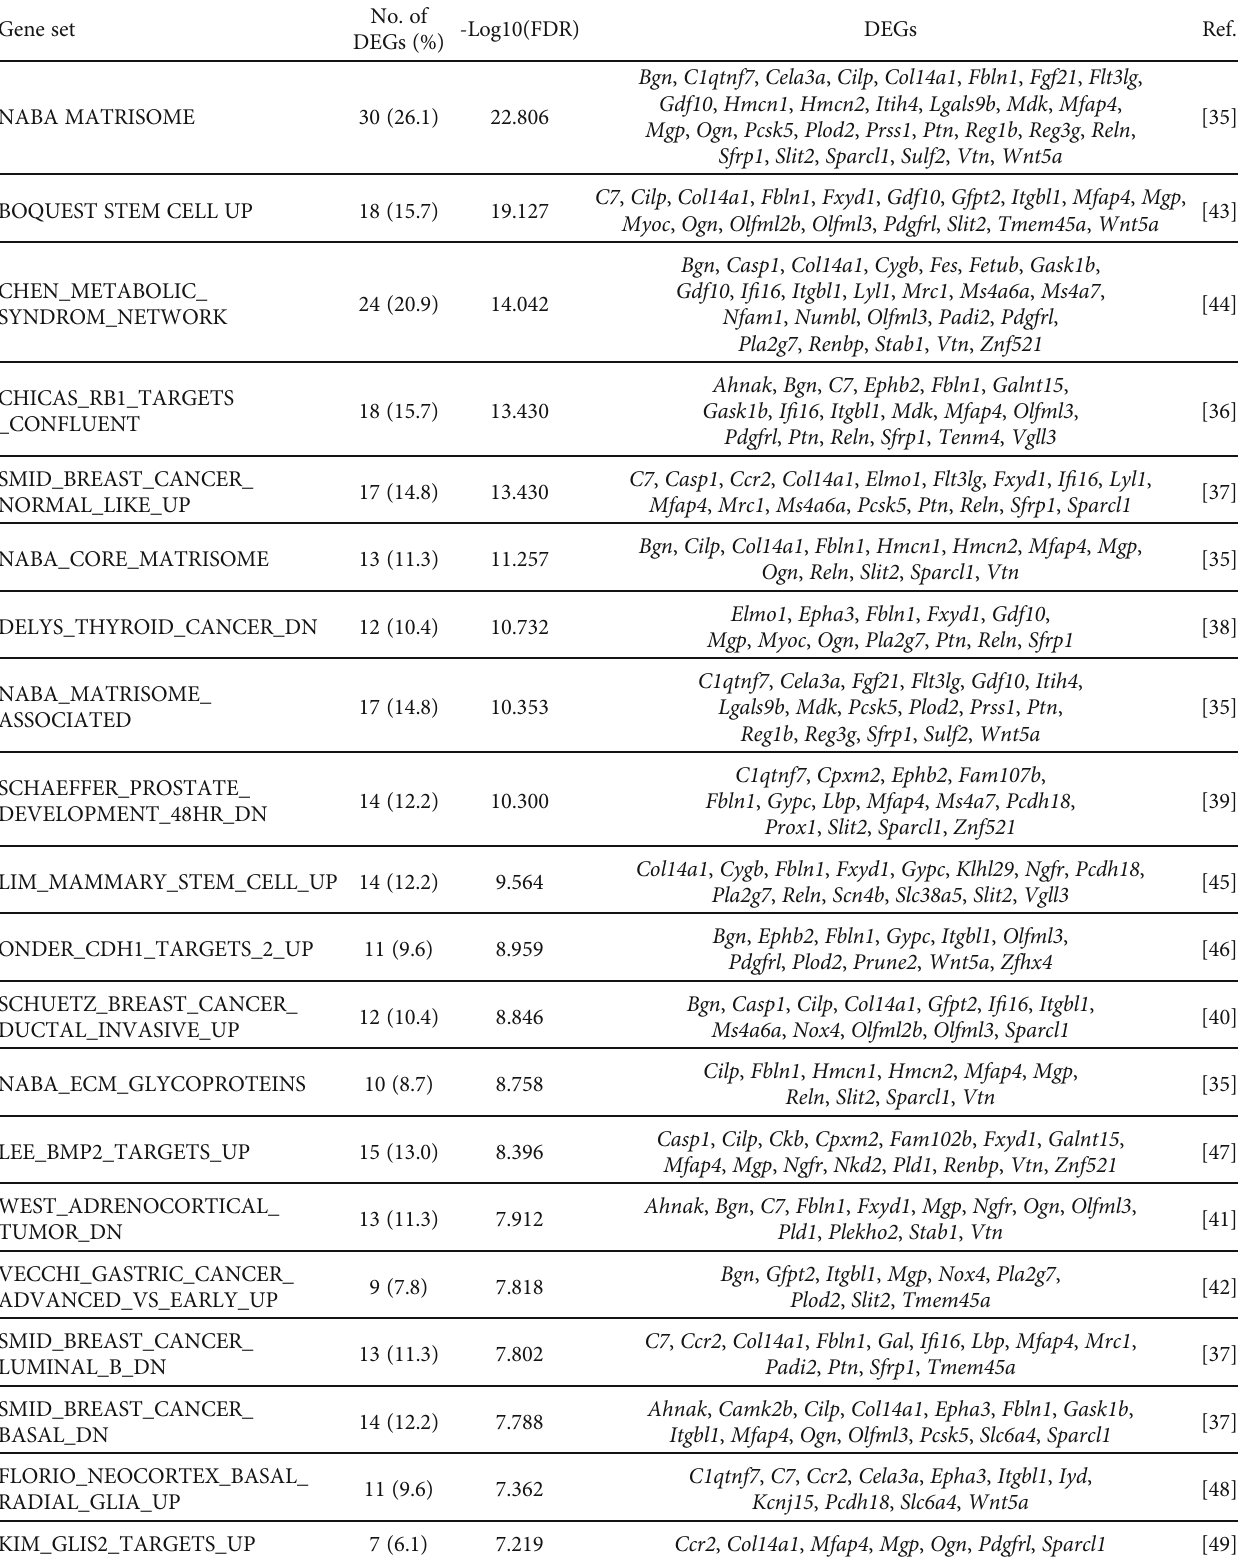
Table 3: Top 20 gene sets enriched in 115 DEGs shared between CP and CPR ∗